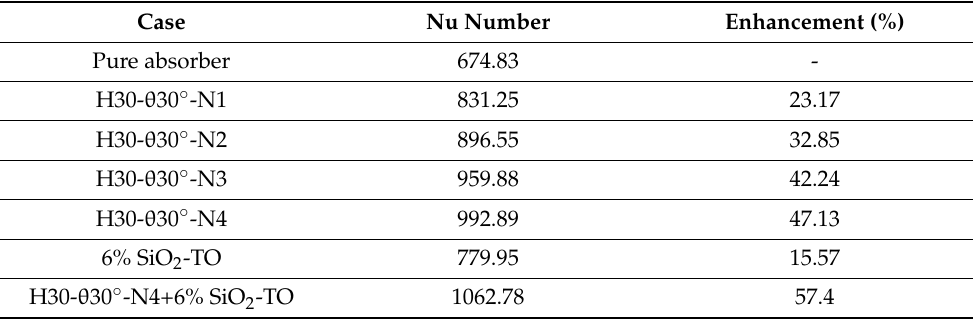
Table 6. Thermal enhancement in the Nu number with single and multiple conical inserts, with and without nanofluid at Re =